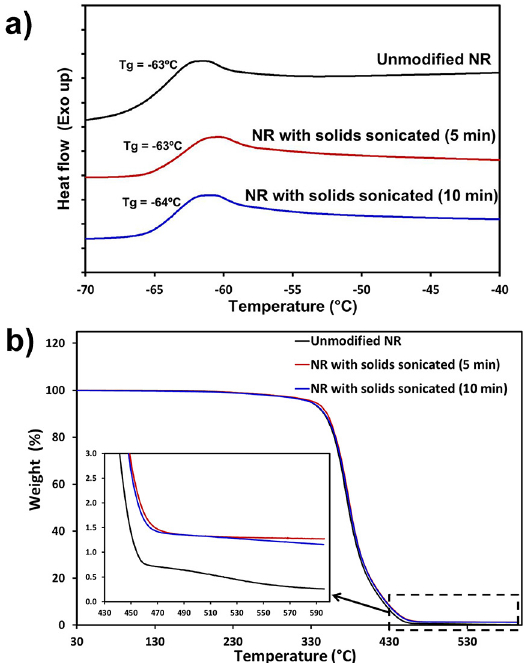
Figure 5. (a) DSC thermograms of the second scan after dynamic curing at 20ºC/min and (b) TGA curves at 10ºC/min in N atmosphere for NR vulcanized films. The inset on (b) represents the char yield at 600ºC.